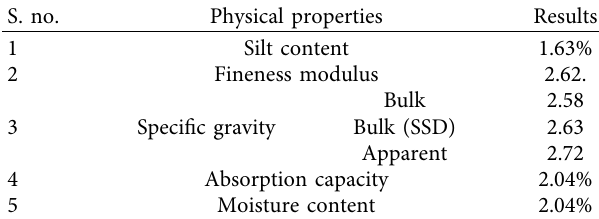
Table 5: Summarized physical properties of the fine aggregate. S.